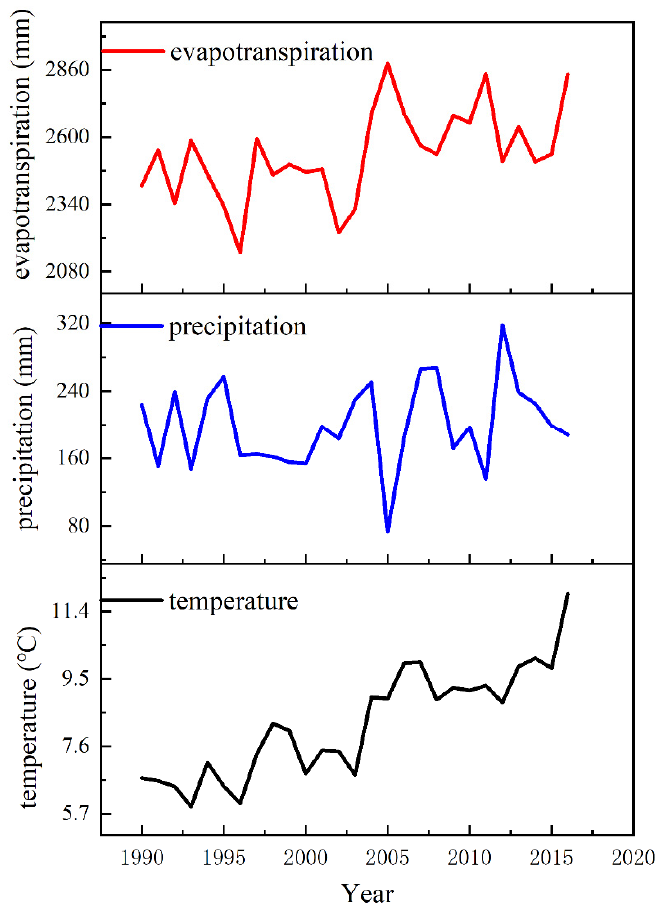
Figure 2. Analysis of temperature, rainfall and evapotranspiration in the study area.